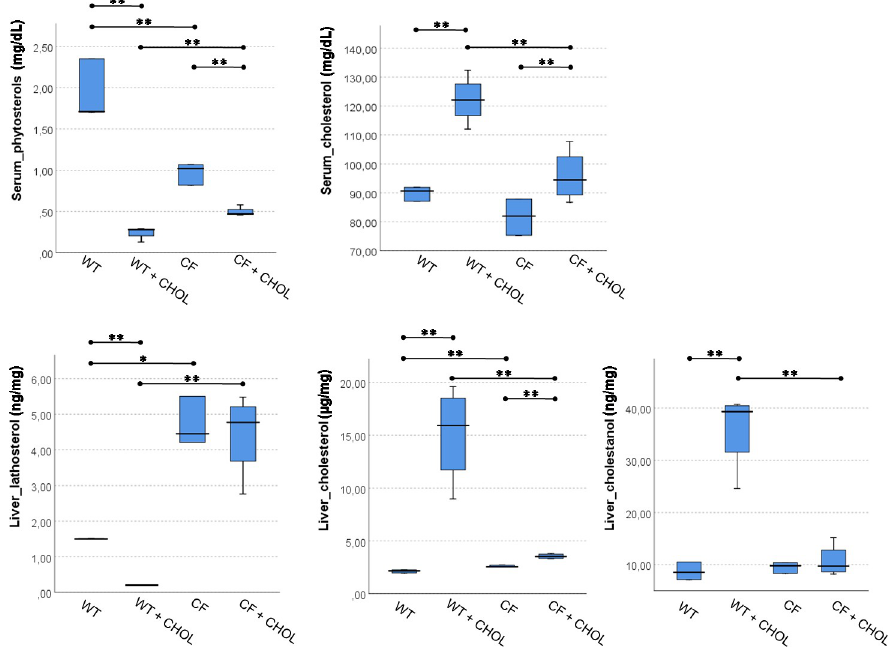
Fig 2. Multiple comparison among WT and CF with and without cholesterol supplementation for serum and liver sterols. The significance of Kruskal-Wallis test for serum phytosterols, liver lathosterol and liver cholesterol was < 0.0001. The significance for serum cholesterol and liver cholestanol was < 0.002. Mann–Whitney U post hoc test: � p < 0.05, �� p < 0.005.